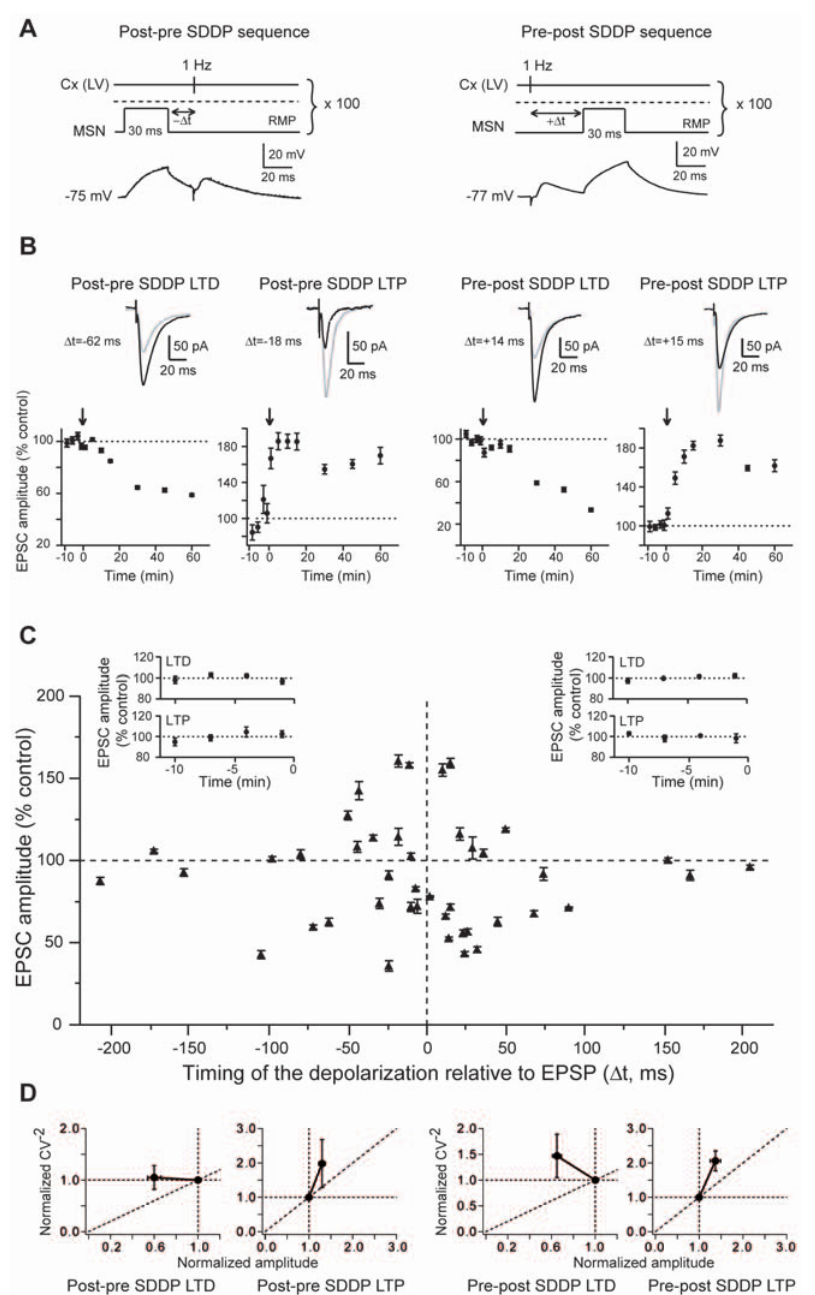
Figure 2. Postsynaptic subthreshold depolarizations paired with presynaptic stimulations induce long-term synaptic plasticity. ( A ) SDDP protocols and the corresponding raw traces of the postsynaptic MSN recordings. Brief subthreshold depolarizations were evoked in the MSN just before (post-pre SDDP sequences) or after (pre-post SDDP sequences) cortical stimulation (100 paired stimulations at 1 Hz). The dashed line indicates the action potential threshold. ( B ) Representative experiments of SDDP for the four observed cases. Long-term synaptic efficacy changes (illustrated by EPSCs evoked in control, black, and 60 minutes after cellular conditioning protocol, grey) were 2 37.5 6 1.4% for post-pre sdLTD ( D t= 2 62 ms), + 60.5 6 4.9% for post-pre sdLTP ( D t= 2 18 ms), 2 47.5 6 2.0% for pre-post sdLTD ( D t= + 14 ms) and + 59.3 6 2.7% for pre-post sdLTP ( D t= + 15 ms) (arrows indicate the cellular conditioning protocols). ( C ) SDDP protocols induce bidirectional long-term synaptic plasticity (each 43 MSN is indicated by black triangle, mean 6 SEM measured 60 minutes after cellular conditioning protocol). Post-pre protocols induced sdLTD or sdLTP for 2 110 , D t , 0 ms (n=19). Pre-post protocols induced mainly sdLTD for 0 , D t , + 110 ms (n=18). No long-term plasticity occurred for D t beyond + / 2 110 ms (n=6). Inserts: Averages of normalized EPSC amplitudes recorded in control before SDDP protocols inducing post-pre sdLTD (n=7), post- pre sdLTP (n=8), pre-post sdLTD (n=12) and pre-post sdLTP (n=4). Control EPSCs amplitudes were recorded for 10 minutes (minus sign indicates time before the SDDP protocol) and displayed no significant variations. ( D ) Normalized CV 2 2 were plotted as a function of the normalized EPSC amplitude to determine the loci of the SDDP. The four graphs illustrate the CV 2 2 plots (from left to right) for post-pre sdLTD, post-pre sdLTP, pre-post sdLTD and pre-post sdLTP. Mean variance analysis suggest that post-pre and pre-post sdLTD has mainly a postsynaptic origin and, post-pre and pre- post sdLTP is mainly underlain by presynaptic mechanisms.